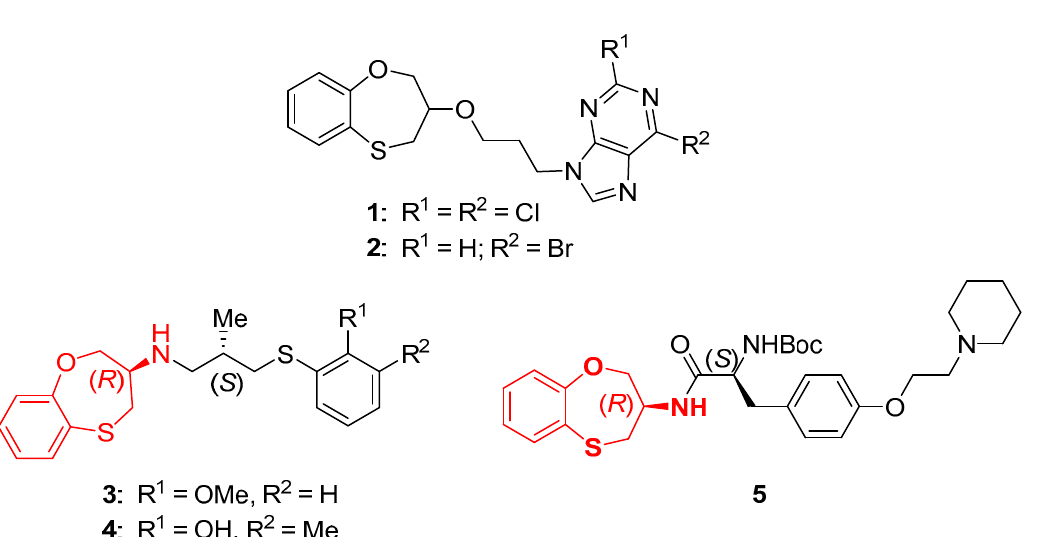
Figure 1. Benzo-fused seven-membered rings with oxygen and sulphur atoms in 1,5 relative positions ( 1 – 5 ) with interesting biological properties [1–5]. The (3 R )-3,4-dihydro-2 H -1,5-benzoxathiepin-3-amine core appears in red in compounds 3 – 5 .